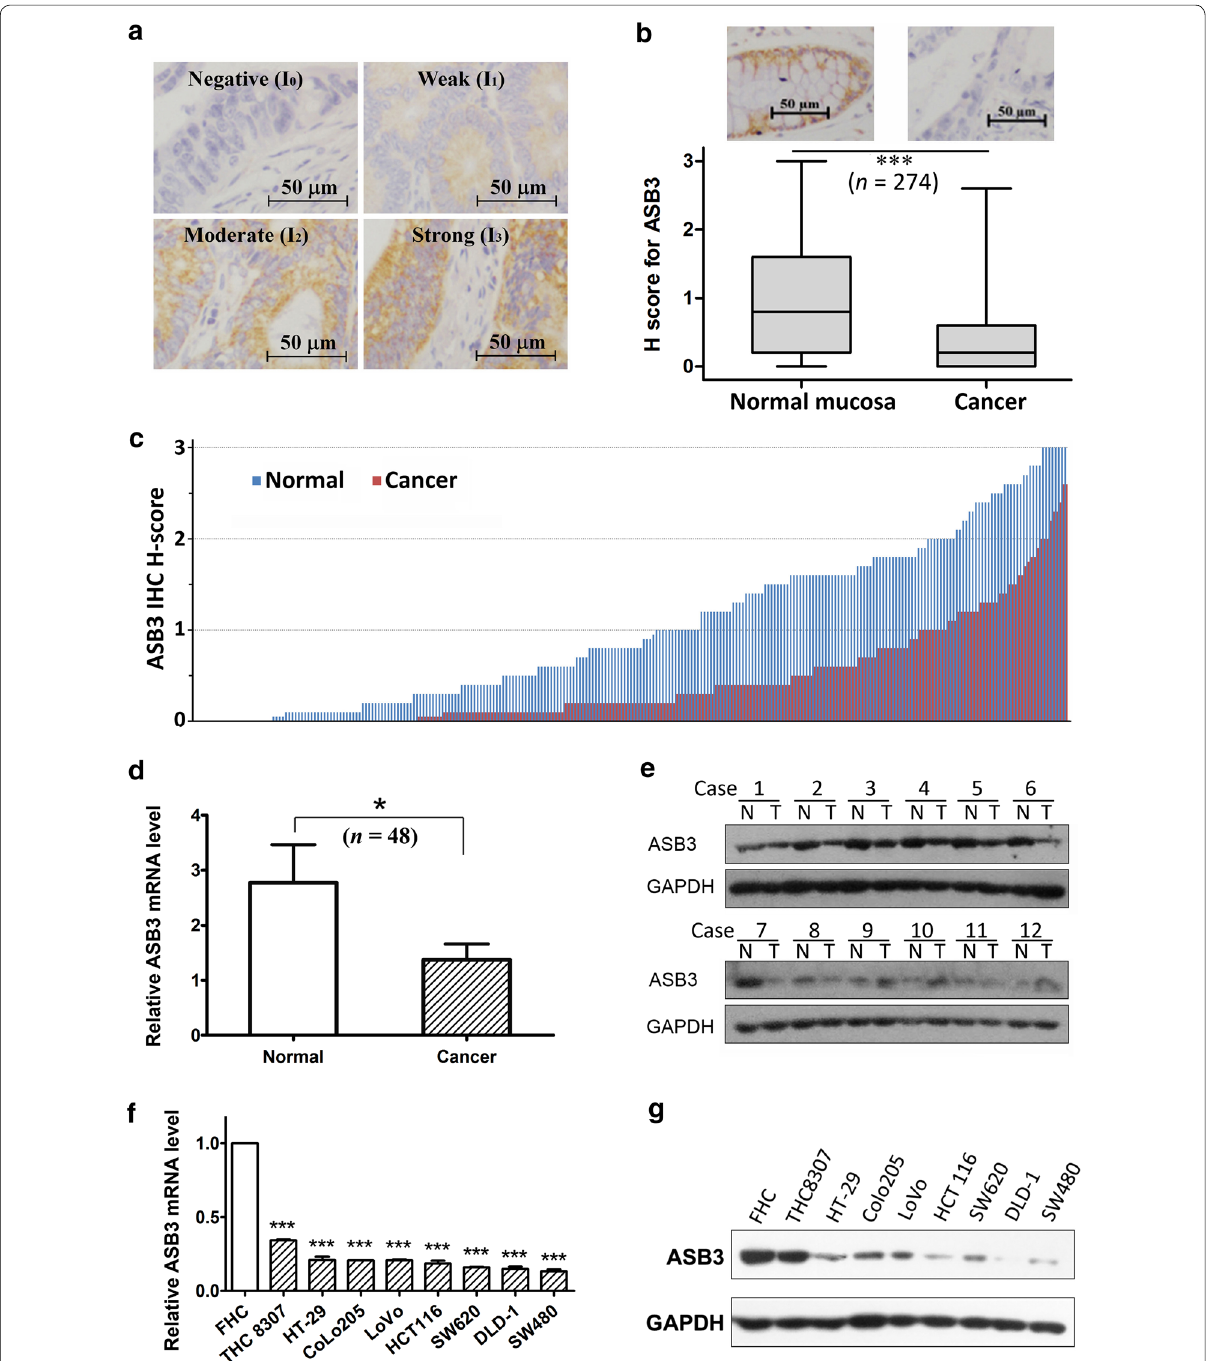
Fig. 1 Ankyrin repeat and suppressor of cytokine signaling (SOCS) box protein 3 (ASB3) is generally down‑regulated in colorectal cancer (CRC) tissues and cell lines. ASB3 expression was detected by immunohistochemical (IHC), real‑time quantitative polymerase chain reaction (qPCR), and Western blotting assays in CRC tissues ( a , b , c , d and e ) and cell lines ( f and g ). a Representative images of IHC staining for ASB3 in CRC tissues. ASB3 protein expression levels were divided into 4 levels: I 0 , negative; I 1 , weak staining; I 2 , moderate staining; I 3 , strong staining. The scale bar repre‑ sents 50μm. b ASB3 protein levels (H score) determined by IHC assay in 274 pairs of CRC and corresponding normal mucosal tissues (*** P < 0.001). c IHC H‑scores ordered from low to high respectively. d The relative mRNA levels of ASB3 in 48 pairs of CRC and corresponding normal mucosal tis‑ sues (normalized against that of glyceraldehyde‑3‑phosphate dehydrogenase [GAPDH] internal control; * P 0.016). e ASB3 protein levels detected = by Western blotting assay in 12 pairs of CRC tissues (T) and corresponding normal mucosal tissues (N). GAPDH was used as a loading control. f ASB3 mRNA levels detected by qPCR in normal intestinal epithelial cell line FHC and 8 CRC cell lines (*** P < 0.001 compared with FHC cells). g ASB3 protein levels detected by Western blotting assay in cell lines; GAPDH was used as a loading